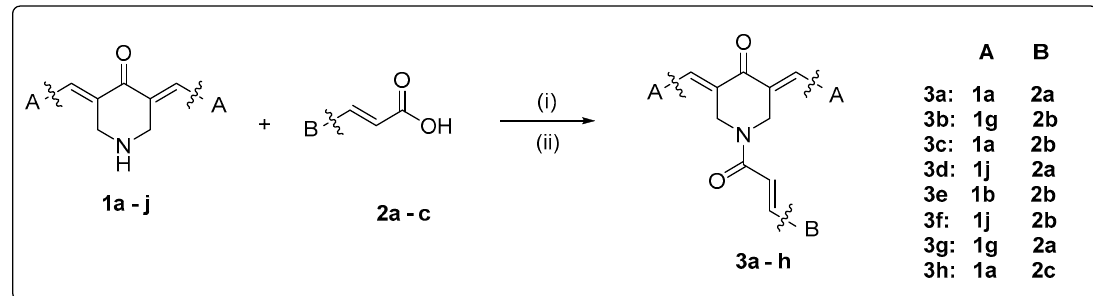
Figure 5. Scaffold combinations and synthetic procedure for the hybridization: ( i ) a mixture of curcumin analogue (1 eq.) with acid (1.5 eq.), HOBT (2 eq.), and EDCI.HCL (3.5 eq.) in dry DMF (3–5 mL) stirring at r.t. under nitrogen or argon gas; ( ii ) a mixture of acid (0.003 mol), thionyl chloride (0.007 mol), N , N -dimethylformamide (0.04 mL), and dry dichloroethane (40 mL) under reflux for 6 h. A curcumin analogue (0.003 mol) was added and cooled in an ice-bath for 20 min. Et3N (0.006 mol) in dichloroethane (20 mL) was added dropwise at the ice-bath temperature.